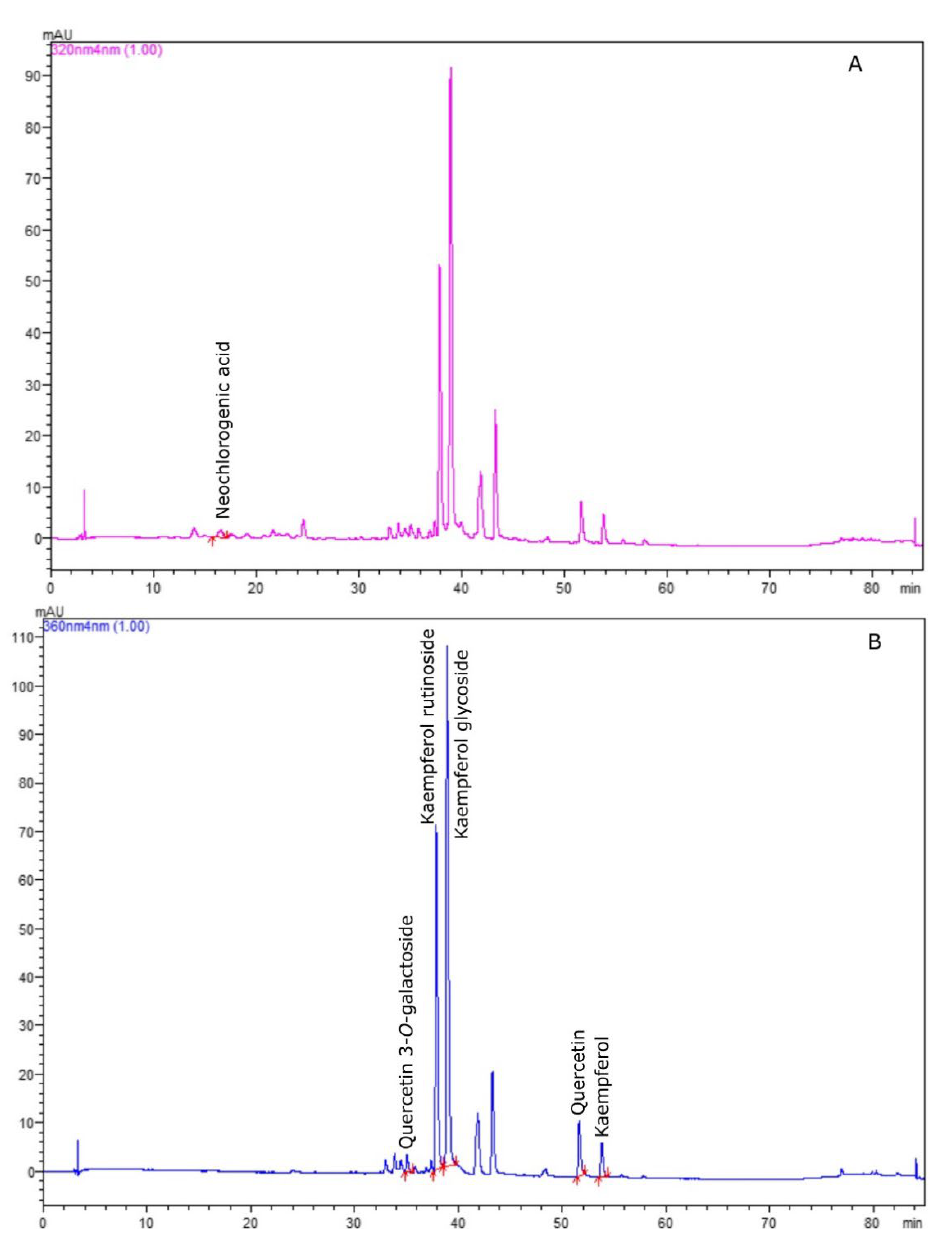
Figure 2. Representative chromatograms of the A. carnea extract at ( A ) 320 nm and ( B ) 360 nm.